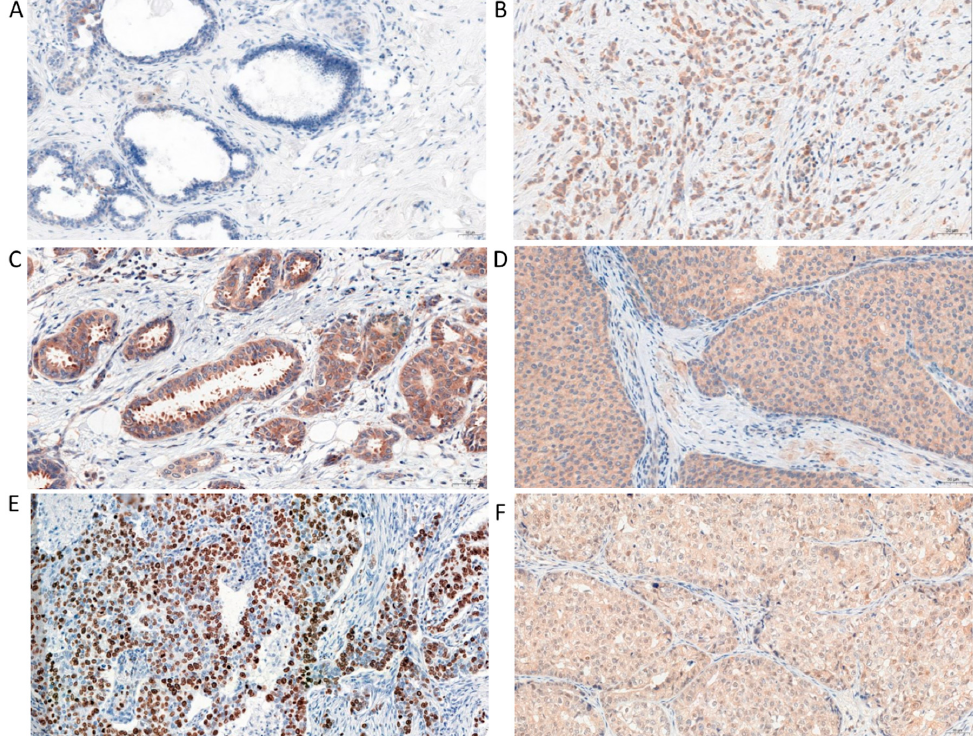
Figure 1. Comparison of irisin expression using immunohistochemistry (IHC; positive reactions— brown cell cytoplasm) in control tissue ( A ) and at different grades of malignancy (G) of breast cancer (BC; ( B )—G1; ( C )—G2, in apical parts of cells; ( D )—G3) with Ki-67 ( E ) and PGC-1 α ( F ); magnification x200.